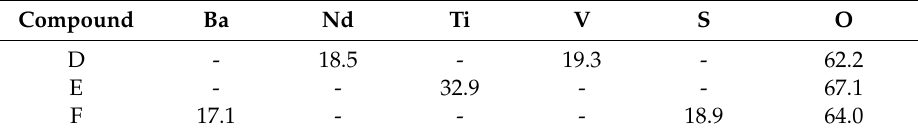
Figure 5. Surface morphologies of BaNd 2 Ti 3 O 10 pellet after Na 2 SO 4 + V 2 O 5 molten salt corrosion at 900 °C for 20 h. ( a ) and ( b ) show the images with different magnifications. Table 2. Chemical compositions of compounds D–F in Figure 5 (in at.%).